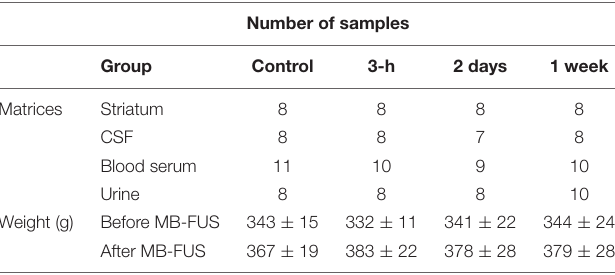
TABLE 1 | Summary of sample sizes by matrix and group and of animal weight (before and after the